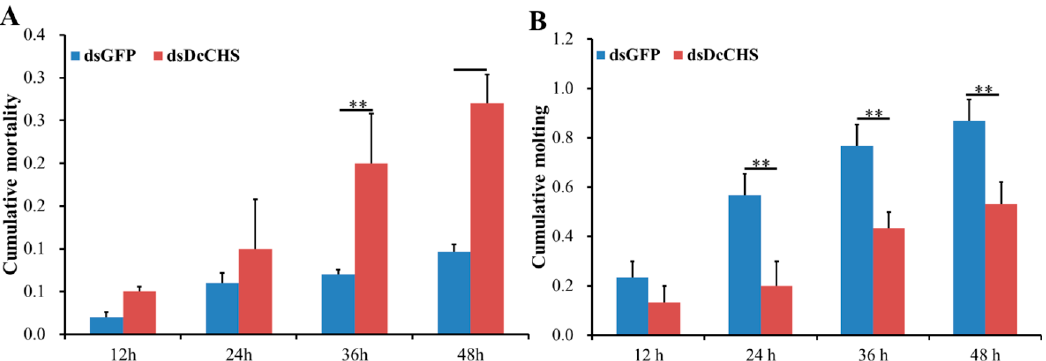
Figure 7. Effects on survival of D. citri after RNA interference (RNAi) of DcCHS . ( A ) Cumulative mortality of D. citri in the treatment (ds DcCHS ) and control (ds GFP ) groups at 12, 24, 36, and 48 h post RNAi treatment. ( B ) Cumulative molting of D. citri in the treatment (ds DcCHS ) and control (ds GFP ) groups at 12, 24, 36, and 48 h post RNAi treatment. The significant differences are indicated by ** ( P < 0.01)